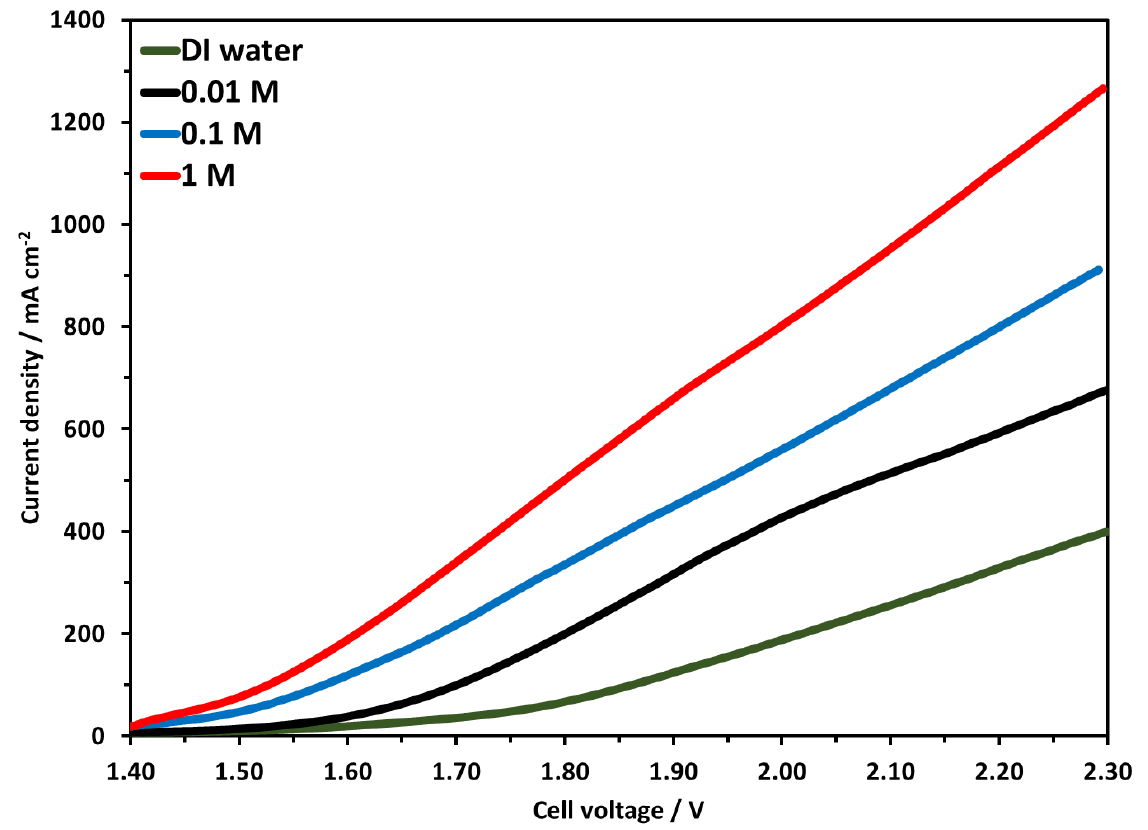
Figure 10. Linear Sweep Voltammetry at temperature of 70 °C with 0.01 M to 1 M KOH concentration. Pt/C was used at the cathode and NiFeCoO x was used at anode. Nyquist plot for KOH concentration of 0.01 M to 1 M and DI water are shown in